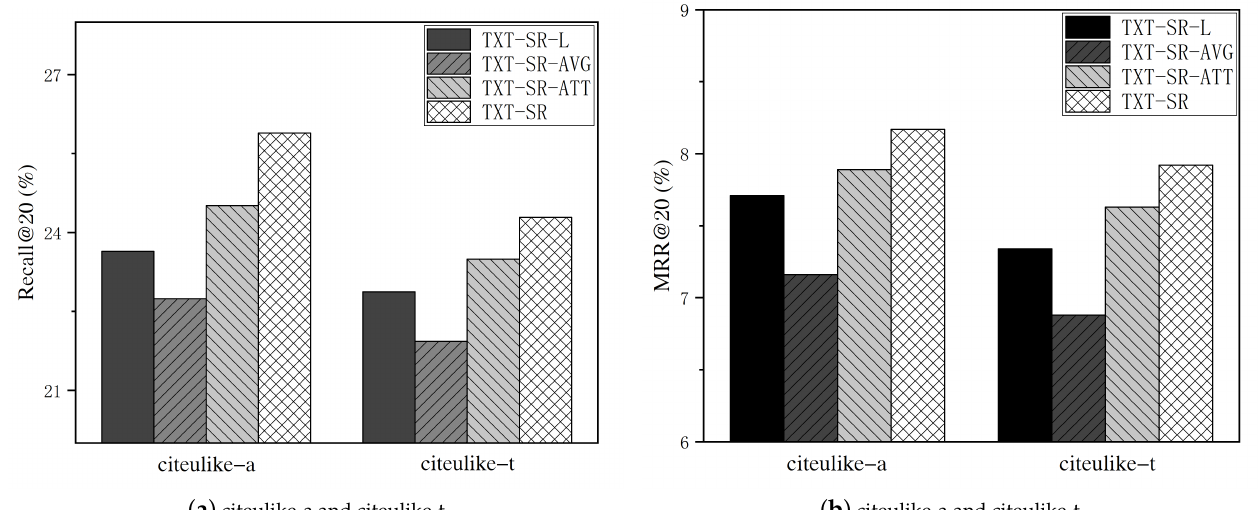
Figure 8. Performance comparison of different session